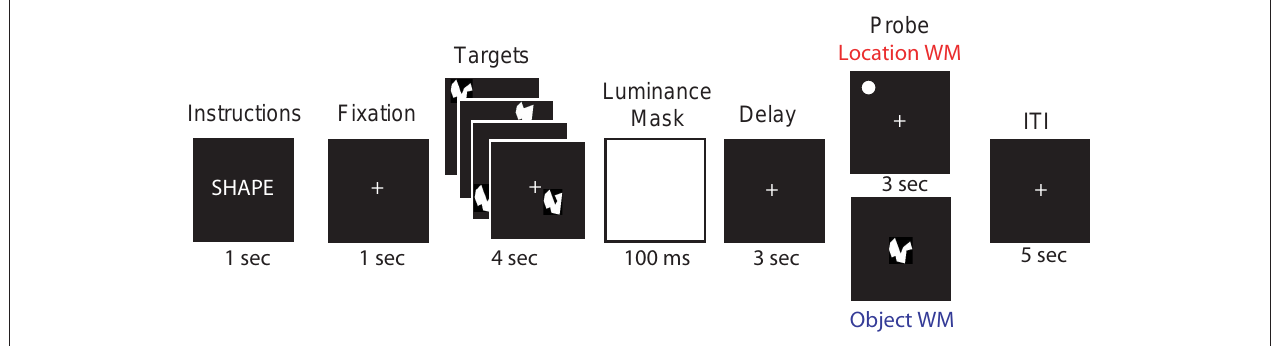
FIGURE 1 | Behavioral task. For each brain area targeted (SPL and S1), subjects performed 192 memory trials (96 location memory and 96 object memory, randomly interleaved). On half the trials, randomly distributed across both memory tasks, a 3-s train of 10-Hz rTMS (30 pulses) coincided with the onset of the delay